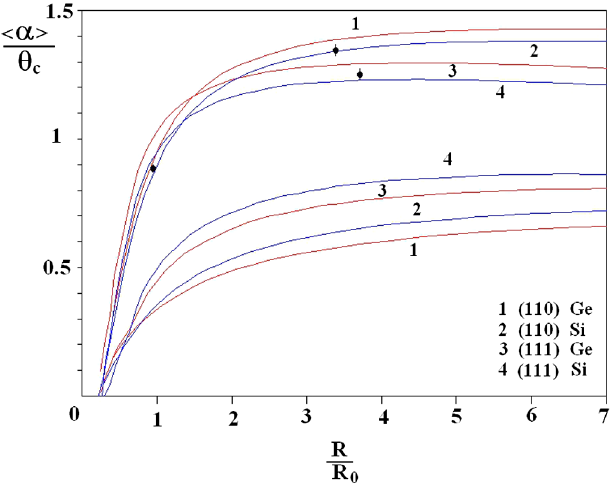
2. The calculated universal functions Ξ ð R=R 0 Þ ¼ h α i = θ c for germanium and silicon single crystals. The Hartree-Fock potentials were used at T D ¼ 290 ° K and 640° K for germanium and silicon, respectively. The upper curves are results for positively charged particles and lower ones are results for negatively charged particles. Three points demonstrated exper- imental data for germanium crystal [8,9] for R ¼ 2 . 3 , 8.2 and 15 meters and l 0 ¼ 2 mm (from left to right, correspondingly). The first and second experimental points correspond to the curve number 1, and the third points correspond to the curve number 3. R 0 ½ m (cid:2) ¼ K R E 0 ½ GeV (cid:2) , where K R ¼ 0 . 0061 , 0.01 for (110) and (111) planes in germanium and K R ¼ 0 . 009 , 0.014 for (110) and (111) planes in silicon,